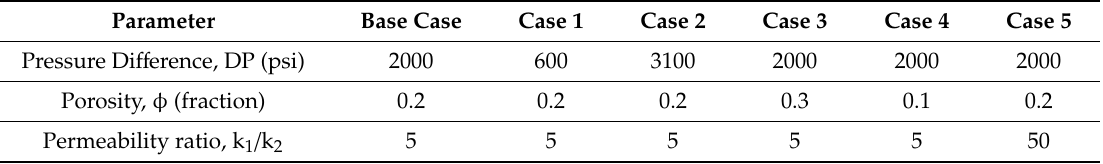
Table 3. Model parameters for the sensitivity analysis scenarios.